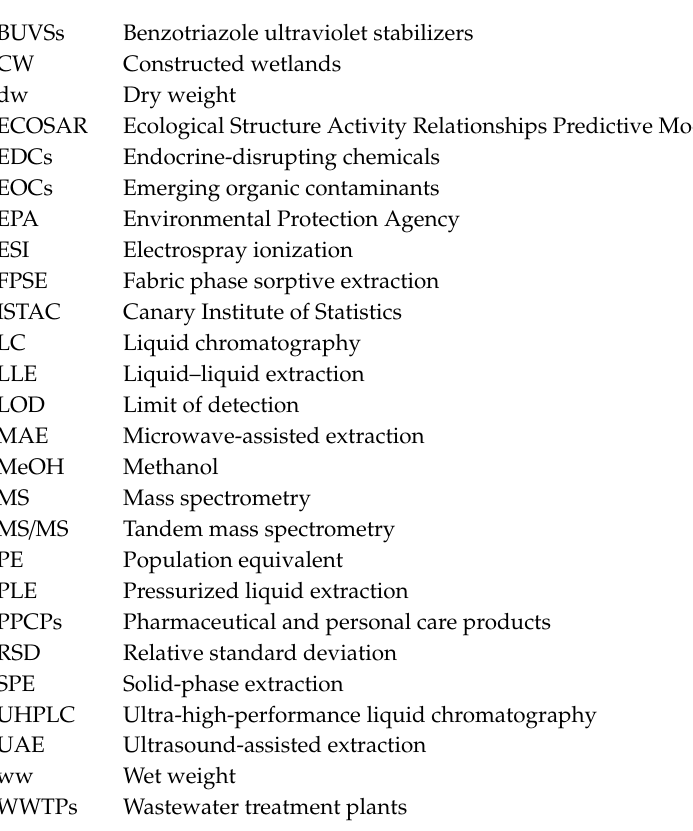
Table S1: SPE conditions employed for each studied family of compounds, Table S2: MAE conditions employed for each matrix and family of studied EOCs, Table S3: Ionization parameters for the selected families of pollutants, Table S4: Mass spectrometer parameters for the studied compounds, Table S5: Chromatographic conditions for selected families of